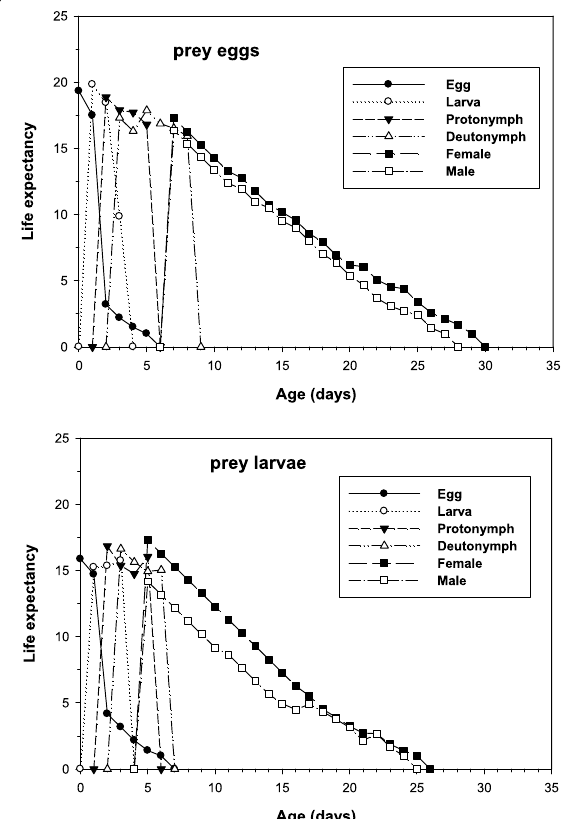
eggs and larvae of Tyrophagus